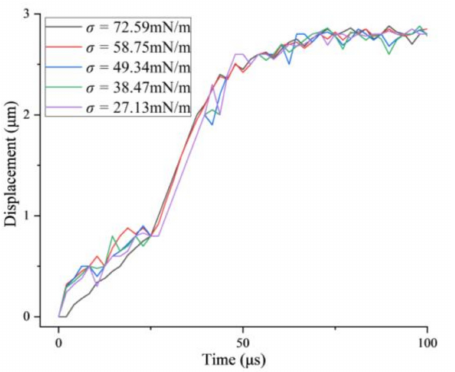
Figure 8. The average displacement of the single bubble versus time in liquids with different surface